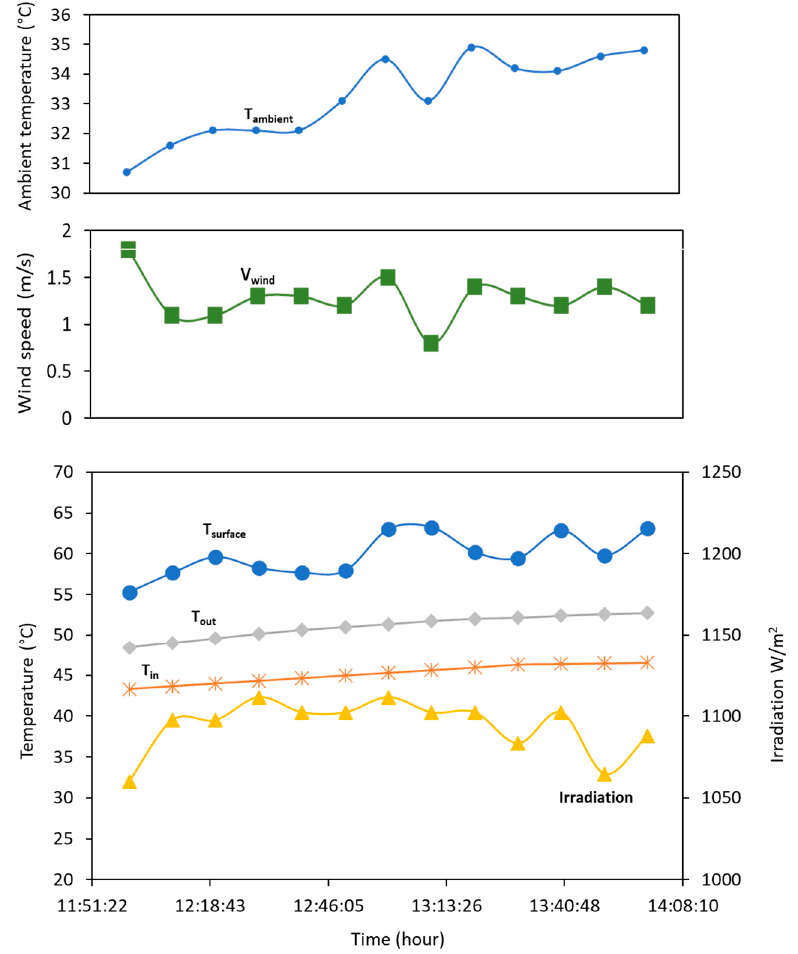
Figure 3. The transient change of the PVT panel intel and exit water temperatures with different weather conditions.